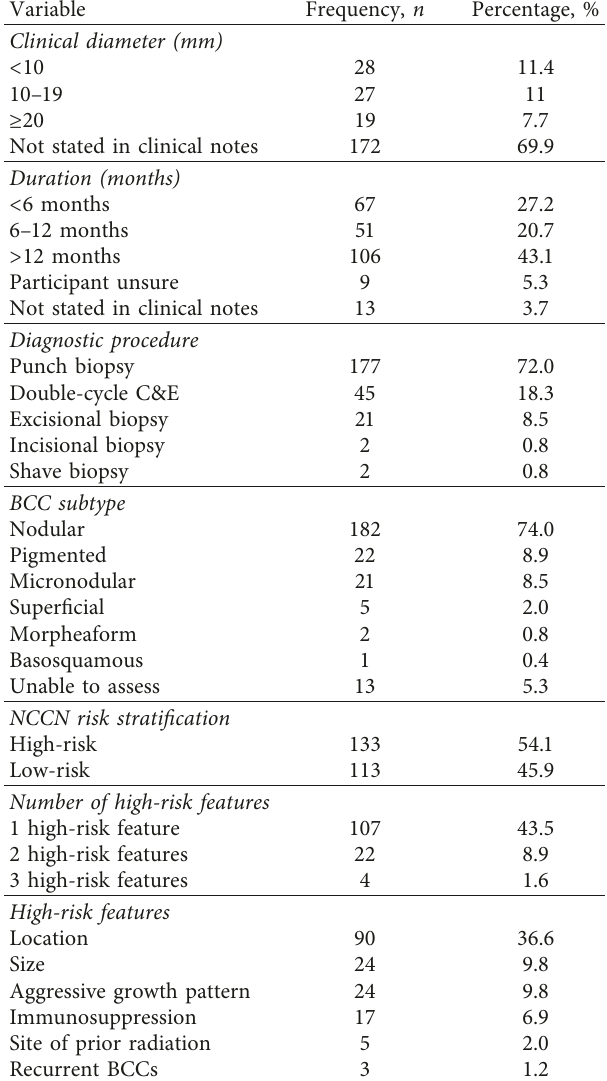
Table 2: Clinical and pathological data of all incident basal cell carcinomas ( N � 246 biopsy samples).